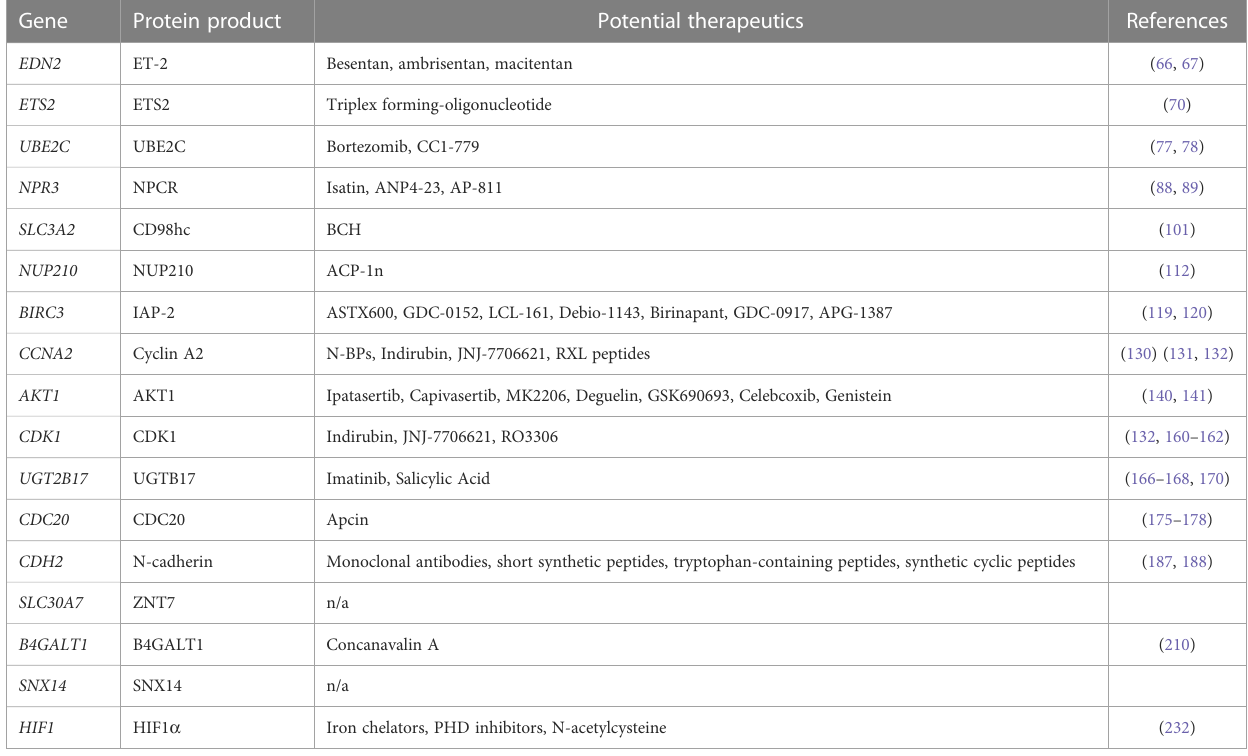
TABLE 3 Druggable strategies targeting protein products of AR-V7 target